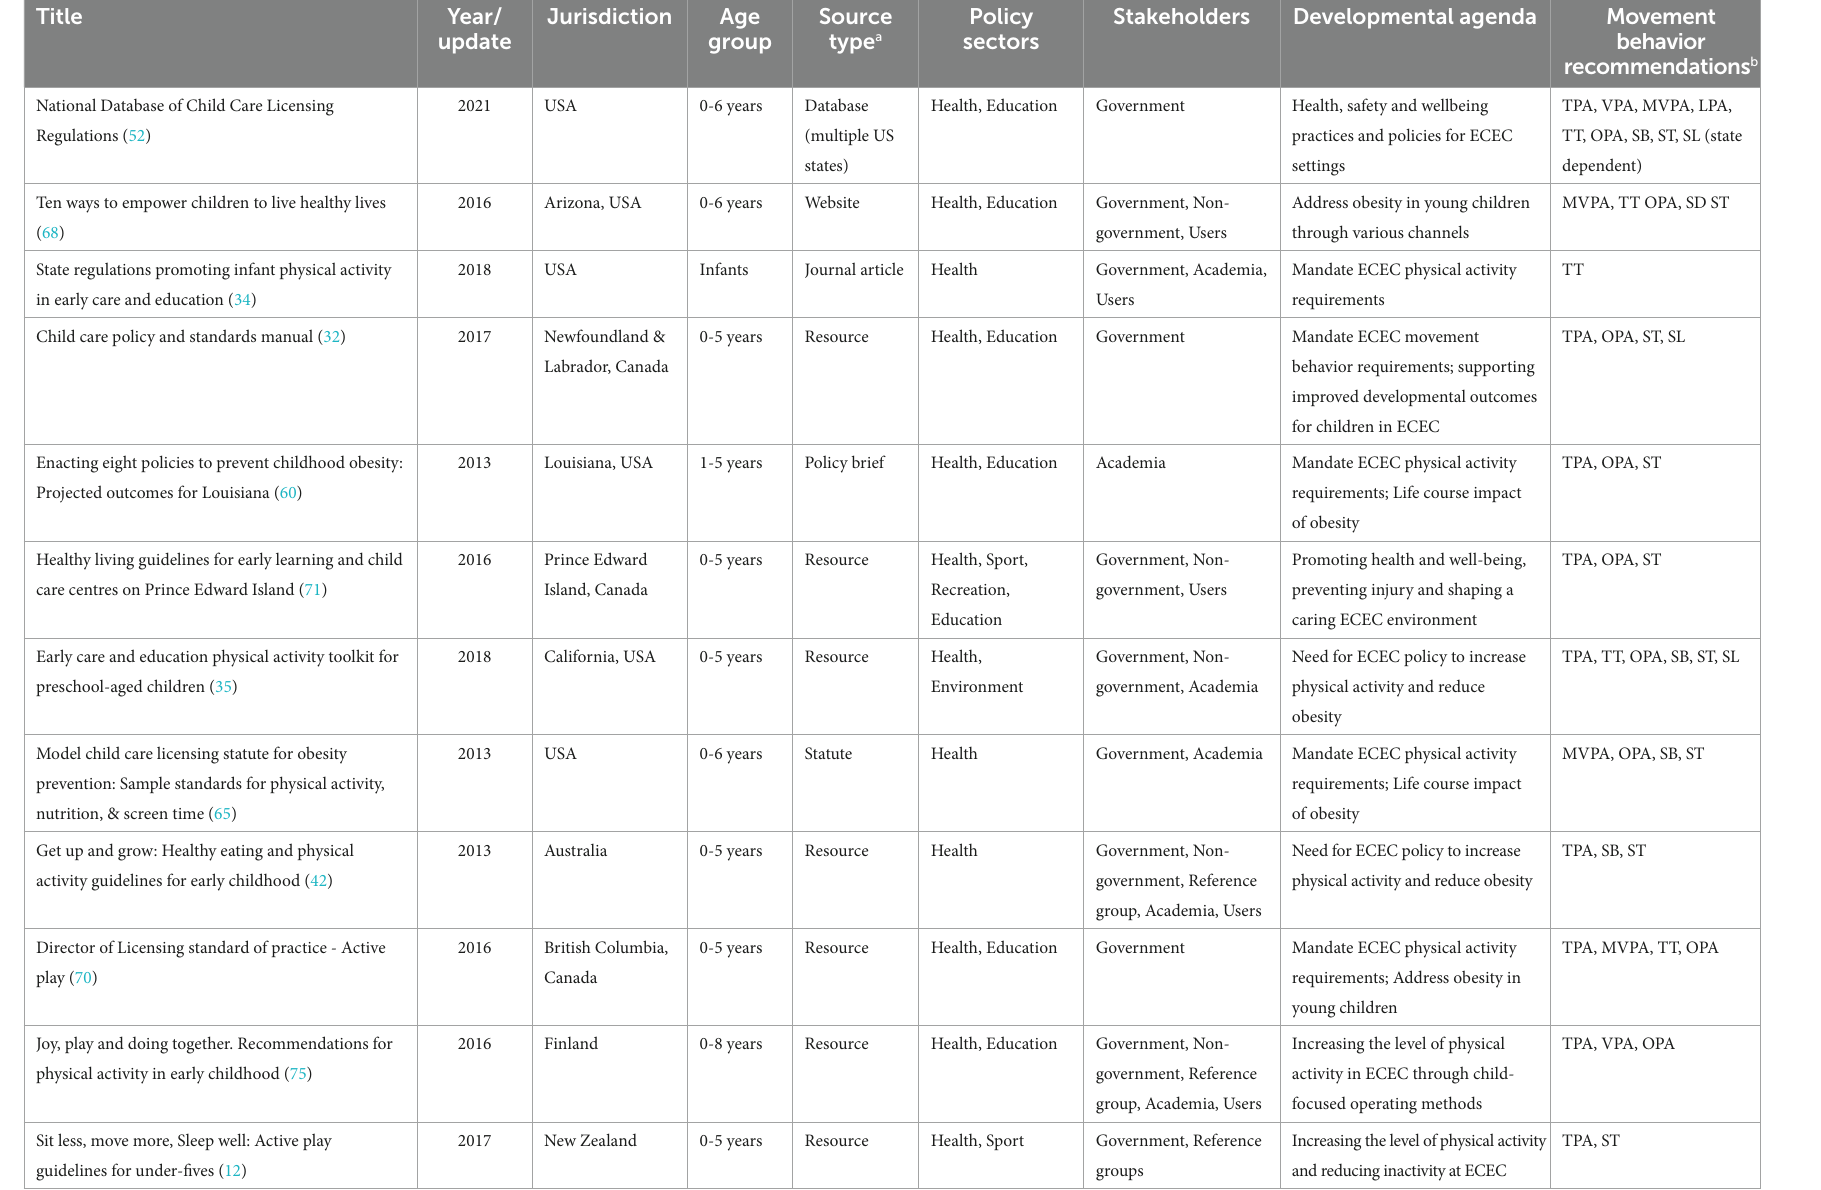
TABLE 2 Summary of included ECEC movement behavior policies, guidelines and recommendations,